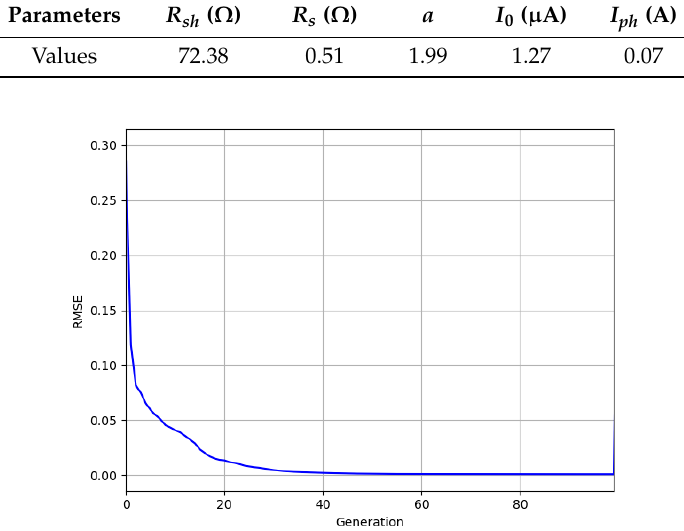
Table 3. Extracted single diode parameter values for the FSTT cell.